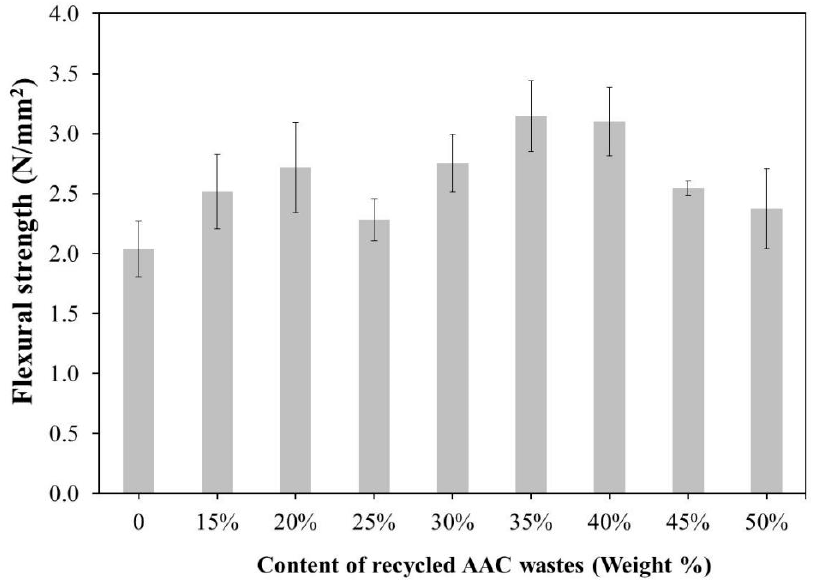
Figure 4. Flexural strength of AAC with different content of fine AAC-R wastes.